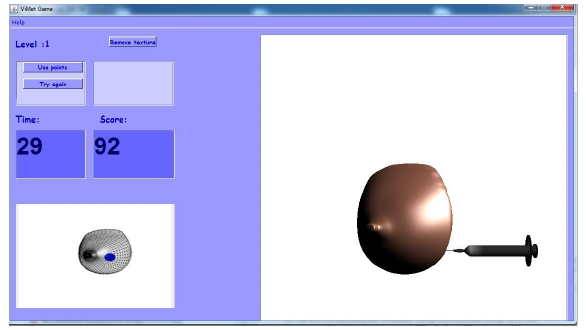
Figure 10. Level of the game with artistically modeled objects.